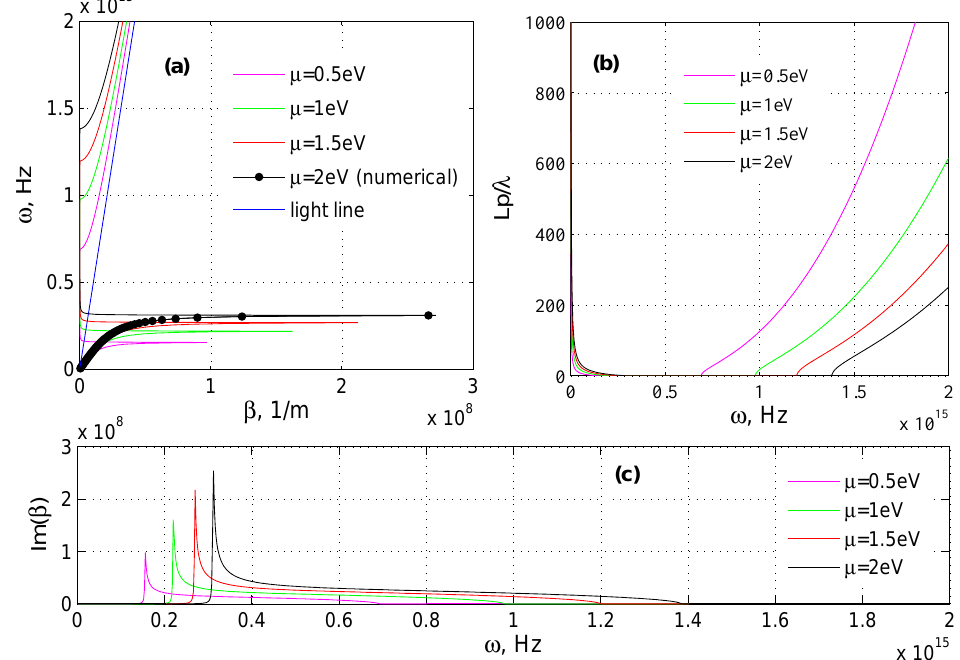
Figure 3. The dispersion of SPPs ( a ); propagation lengths ( b ) and absorption ( c ) at different Fermi energy, where number of graphene layers, i.e. N = 1, d d = 10 nm, ε 1 = ε 3 , ε 2 = ε 4 and d 1 (cid:54) = d 2 (cid:54) = d 3 (cid:54) = d 4 and the blue line in ( a ) denotes the free space light line.